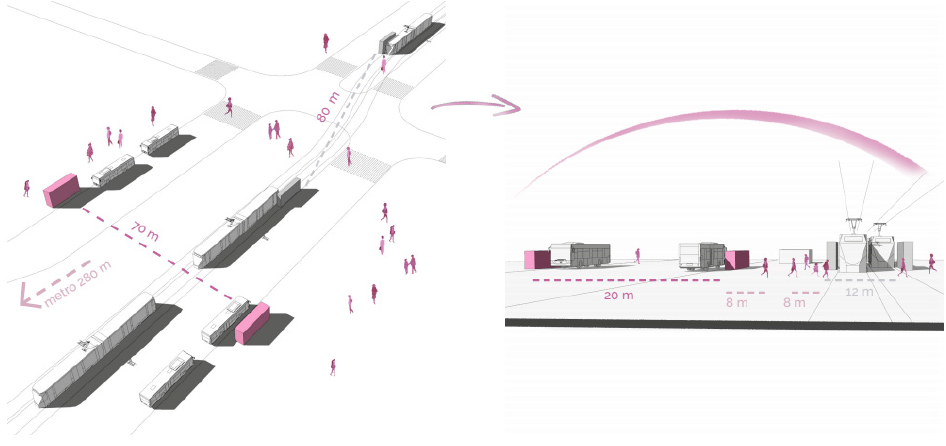
Figure 6. The reduction of the distance between the bus stops and improvements around the pedes- trian crossing.